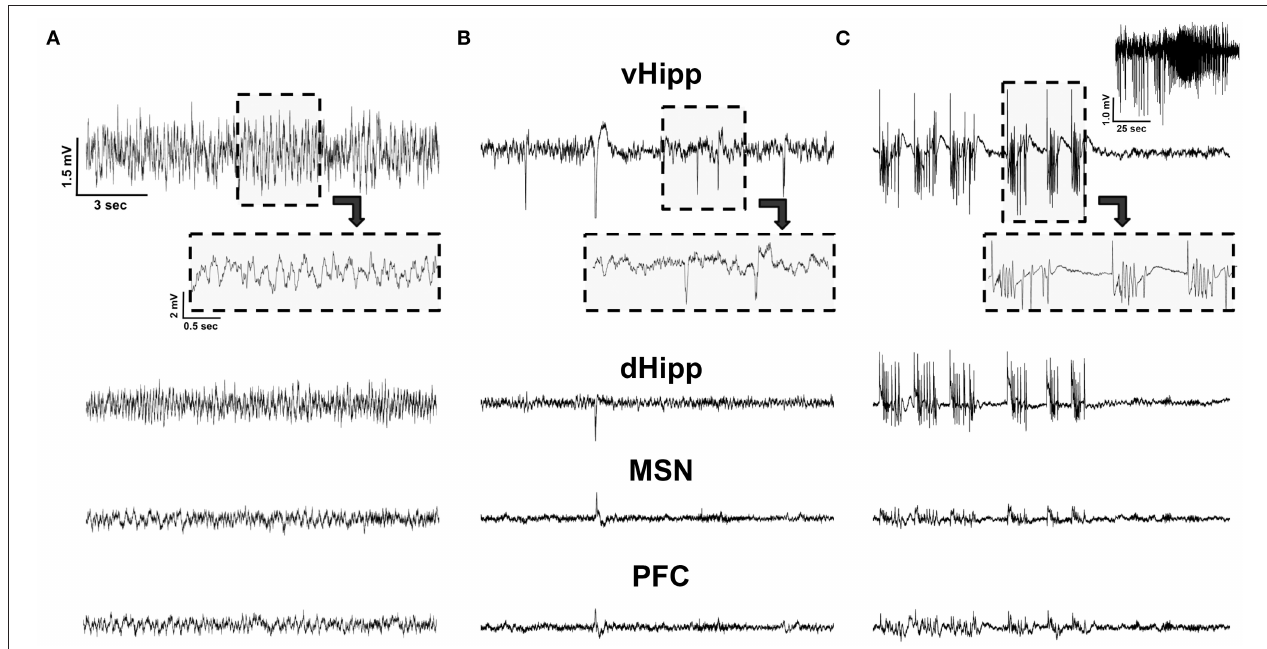
FIGURE 2 | LFP recordings. (A) An example of LFP traces in a Vehicle animal from the ventral (vHPC) and dorsal (dHPC) hippocampus, medial septal nucleus (MSN), and pre-frontal cortex (PFC). (B) Pilocarpine-injected animals exhibited spikes; all detected spikes could be observed in the vHPC, with only a subset detected in the more remote MSN and PFC. (C) Pilocarpine-injected animals also exhibited spontaneous seizures. This electrographic activity represents a visually confirmed seizure with the entire seizure recorded from the vHPC depicted on the top right. Note, while the activity was highly synchronized and observable across channels, seizure amplitude was maximal in the vHPC and was minimal in MSN and PFC. All traces are on the same